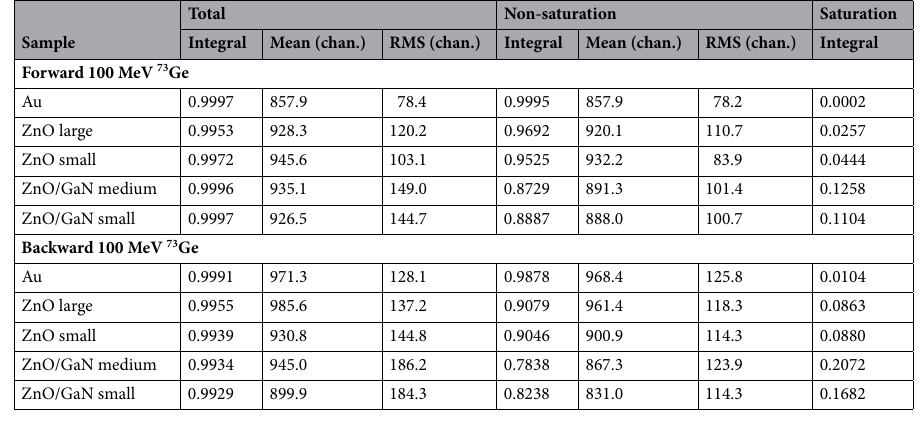
Table 1. Summarized results from the experiment with 100 MeV 73 Ge